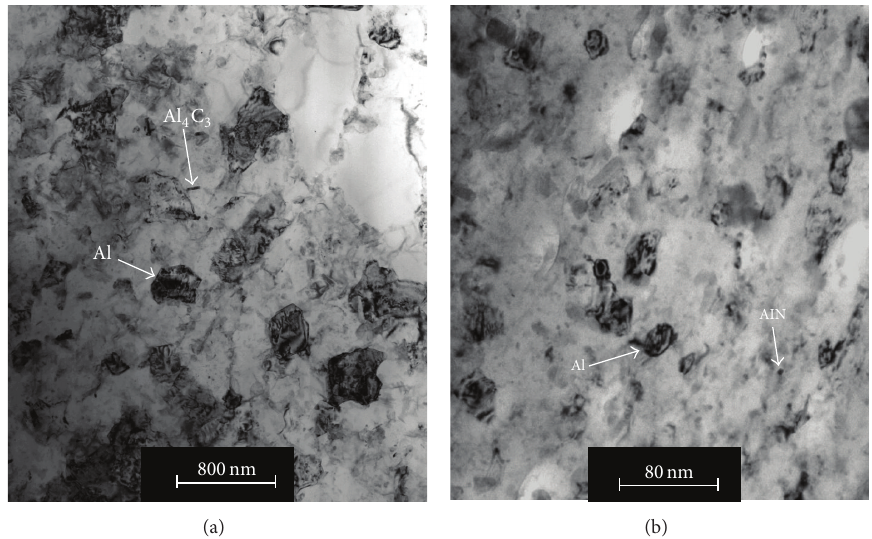
Figure 6: Bright-field TEM images of sintered compacts showing different phases formed in (a) MAV 500-5 S and (b) MAA 500-5 S.